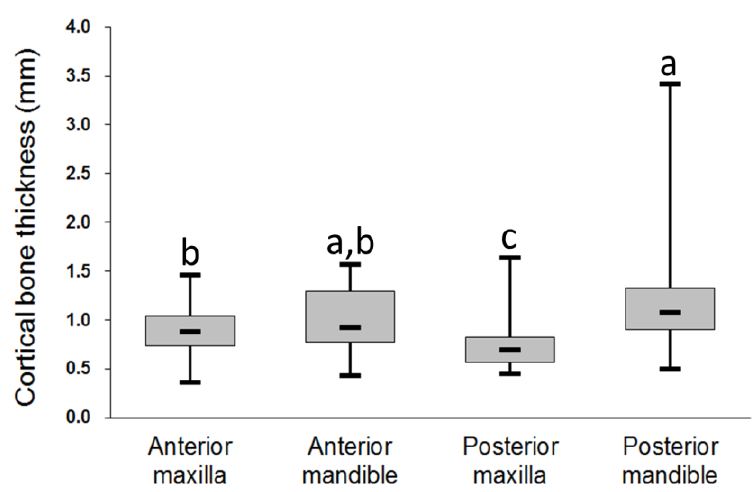
Figure 4. Cortical bone thickness at dental implant sites in different regions of the jawbone. Post hoc pairwise comparisons were conducted using Scheffe’s test; use of the same letter indicates no significant difference at the 0.05 level.